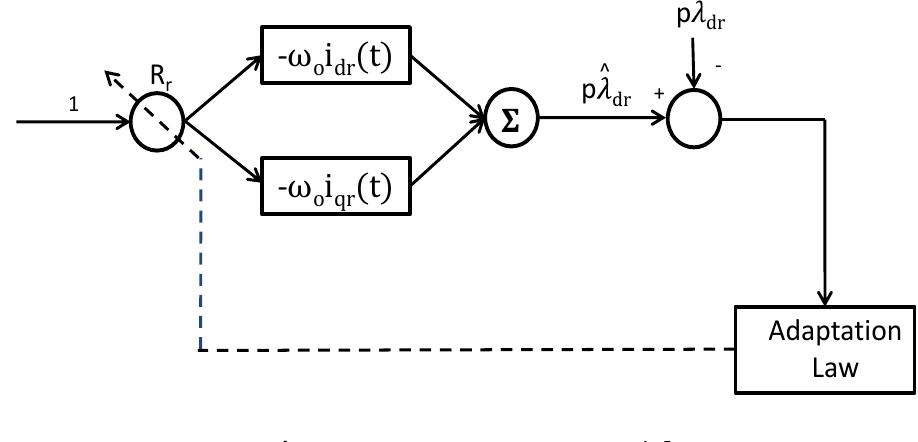
Figure 4. ANN ADALINE